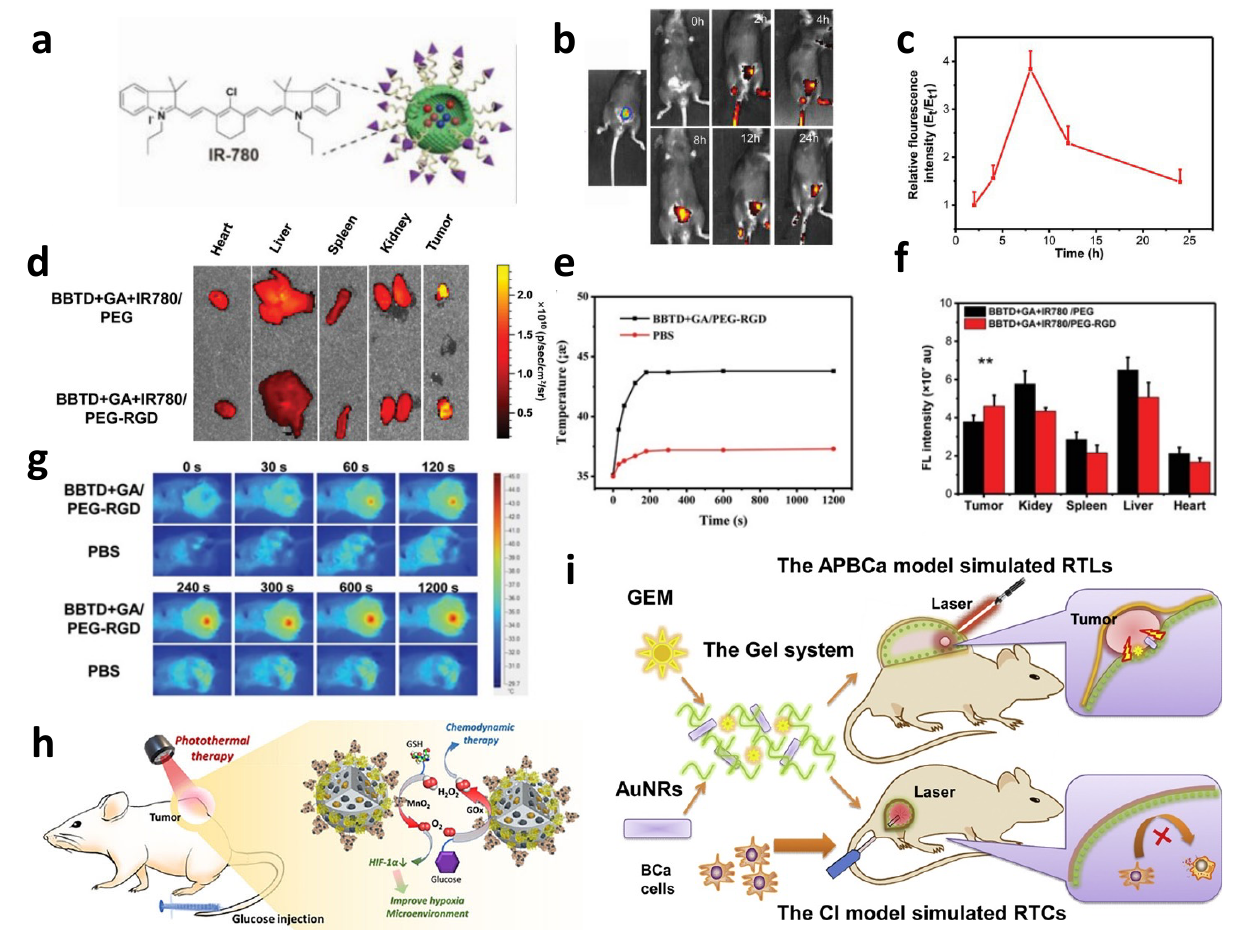
Figure 11. ( a ) Schematic of fluorescent BBTD+GA+IR780/PEG ‐ RGD nanoparticles. ( b ) In vivo tumor, fluorescence imaging after BBTD+GA+IR780/PEG ‐ RGD nanoparticles injected into the vein. ( c ) Changes in tumor fluorescence after BBTD+GA+IR780/PEG ‐ RGD nanoparticles were injected into the vein. ( d ) Ex vivo fluorescence images of diverse tumors and organs. ( e ) Image of tumor temperature over time under 808 nm laser irradiation. ( f ) Fluorescence intensities of different organs. ** p < 0.01 for group of BBTD+GA+IR780/PEG compared with group of BBTD+GA+IR780/PEG ‐ RGD in tumors. ( g ) Whole mice bodies infrared thermal images after 808 nm laser irradiation (0.8 W cm − 2 , 20 min). (Reprinted with permission Ref. [123]. Copyright © 2021 Wiley ‐ VCH GmbH.) ( h ). Schematic of chemodynamic therapy and glucose/glutathione co ‐ triggered tumor hypoxia relief. (Reprinted with permission Ref. [124]. Copyright © 2021 American Chemical Society.) ( i ) Schematic of the single instillation of the gel system. (Reprinted with permission Ref. [125]. Copyright © 2018 Elsevier B.V.).